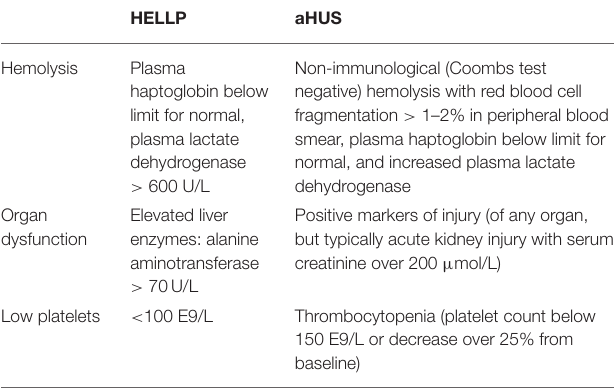
TABLE 1 | HELLP and aHUS diagnostic